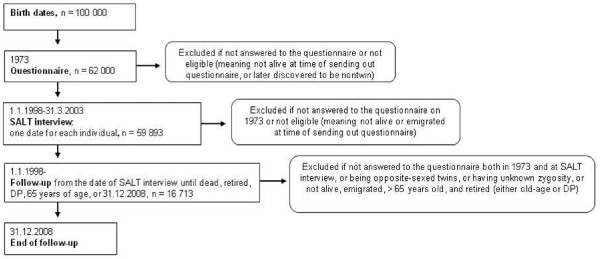
Flow-chart of study time line.